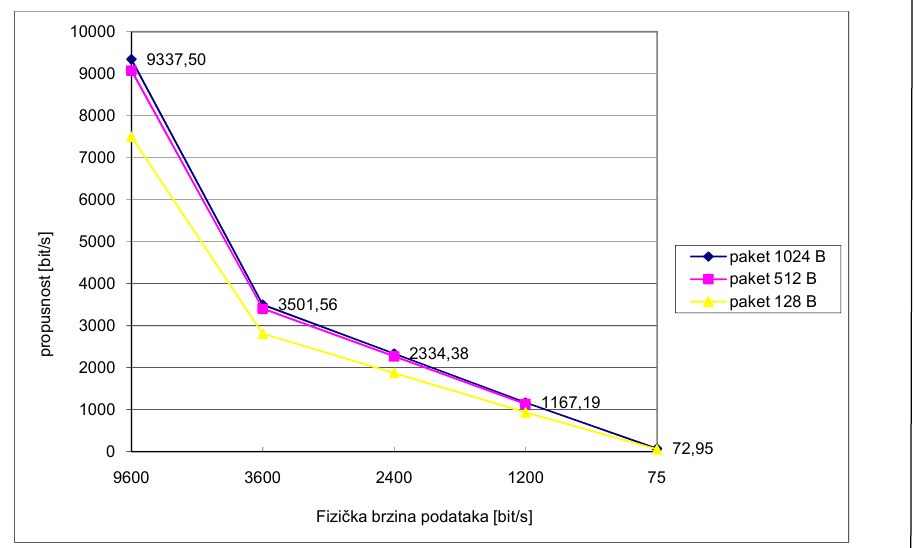
Figure 3 – UDP protocol and physical layer throughput versus a type of